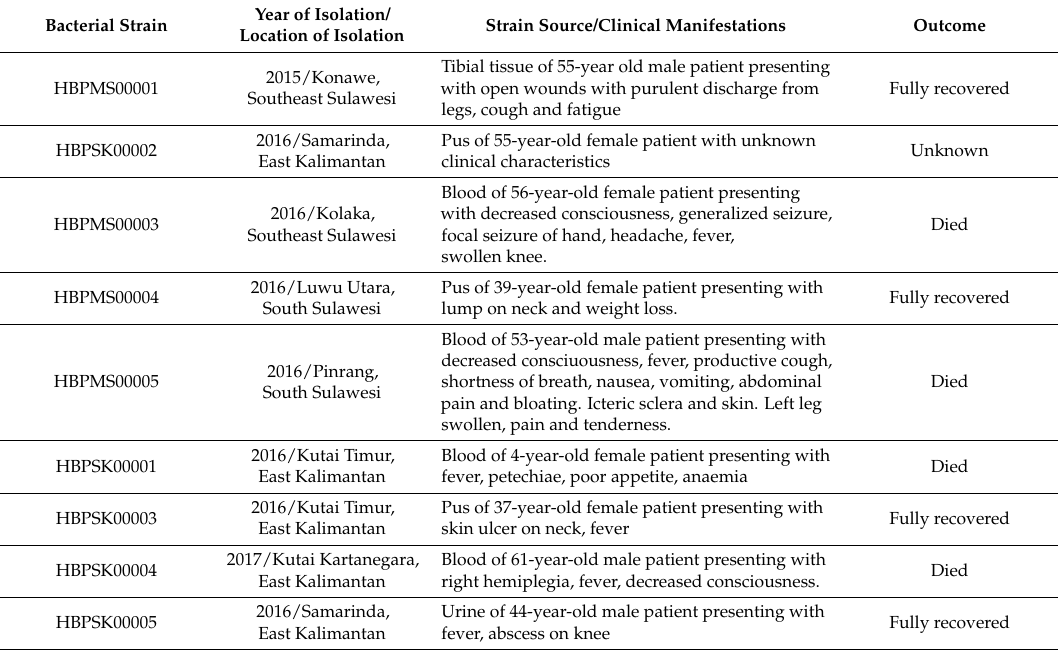
Table 5. Demographics of nine patients with B. pseudomallei confirmed with PCR assays *. Year of Isolation/ Bacterial Strain Strain Source/Clinical Manifestations Outcome Location of Isolation Tibial tissue of 55-year old male patient presenting 2015/Konawe, HBPMS00001 with open wounds with purulent discharge from Southeast Sulawesi legs, cough and fatigue 2016/Samarinda, Pus of 55-year-old female patient with unknown East Kalimantan clinical characteristics Blood of 56-year-old female patient presenting 2016/Kolaka, with decreased consciousness, generalized seizure, Southeast Sulawesi focal seizure of hand, headache, fever, swollen knee.